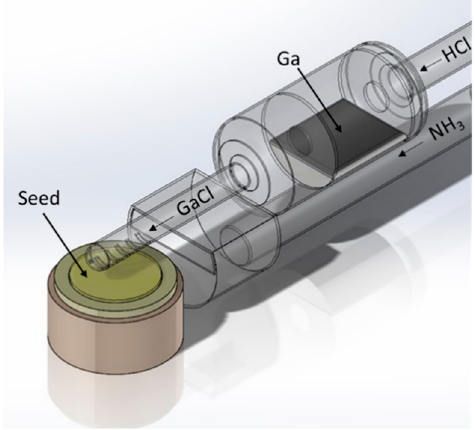
Figure 4. Scheme of horizontal HVPE reactor working at IHPP PAS. All reactants are transported by carrier gas.